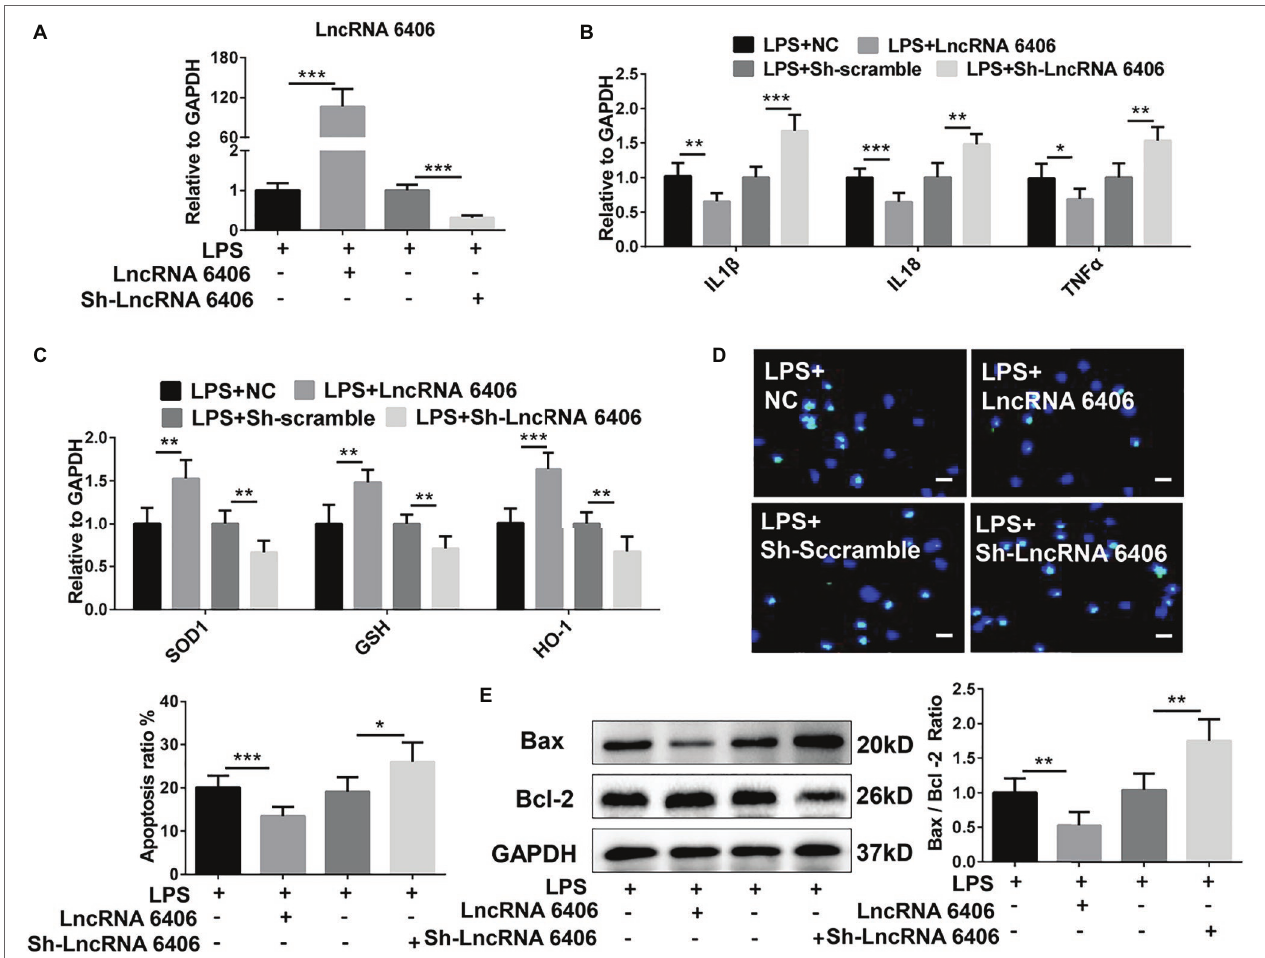
FIGURE 3 | The function of lncRNA 6406 in LPS-stimulated AKI was determined. (A) The transfection efficacies of the lncRNA 6406 overexpressing vector (pcDNA-LncRNA 6406) or knockdown vector (Sh-LncRNA 6406) were verified in the PTEC cells via RT-PCR assays ( n = 6). (B,C) LncRNA 6406 overexpression inhibited the LPS-induced upregulation of pro-inflammatory cytokines (including IL-1 β , TNF- α , and IL-8) and oxidative stress-related proteins, while lncRNA 6406 knockdown showed the opposite effect on the PTEC cells ( n = 6). (D,E) LncRNA 6406 attenuated LPS-induced apoptosis, and lncRNA 6406 inhibition further promoted LPS-induced apoptosis in vitro ( n = 6), scale bar = 10 μ m. Each experiment was conducted independently three times. *p < 0.05; **p < 0.01; ***p < 0.001; versus respective